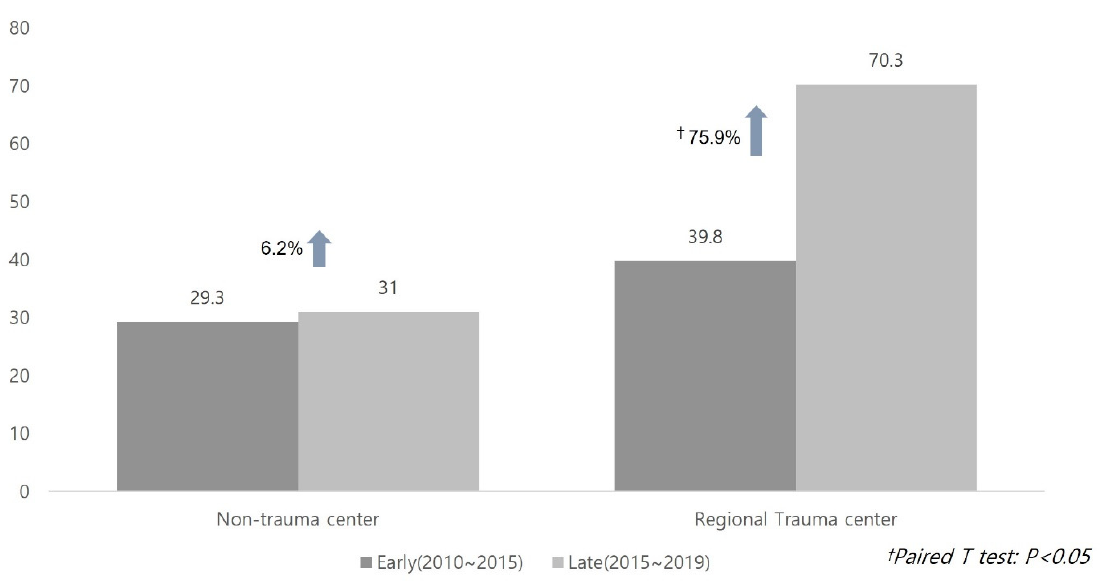
Figure 2. Changes in recruitment of deceased donors at regional trauma centers and non-regional trauma centers. trauma